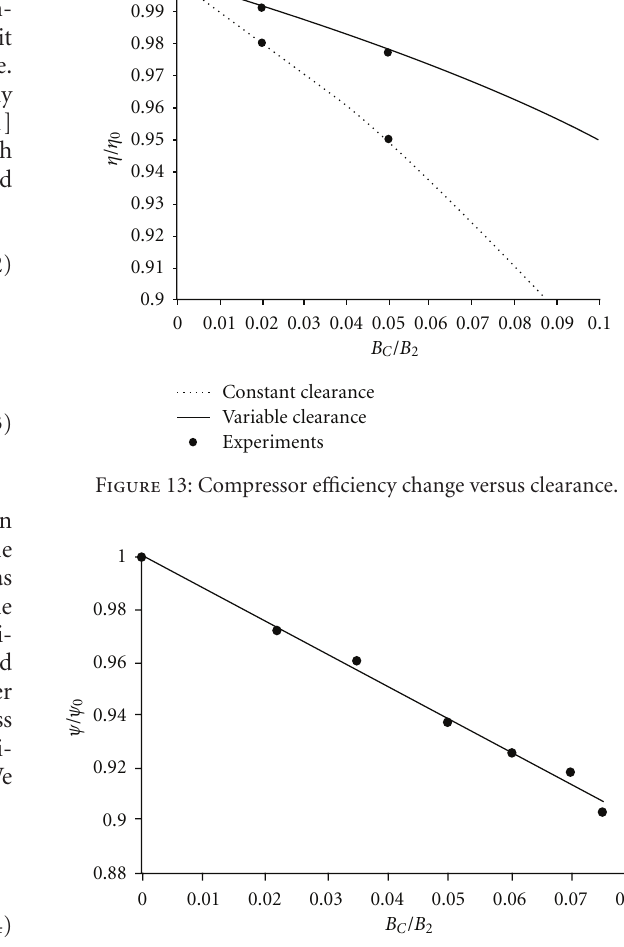
Figure 14: Head coe ffi cient change with tip